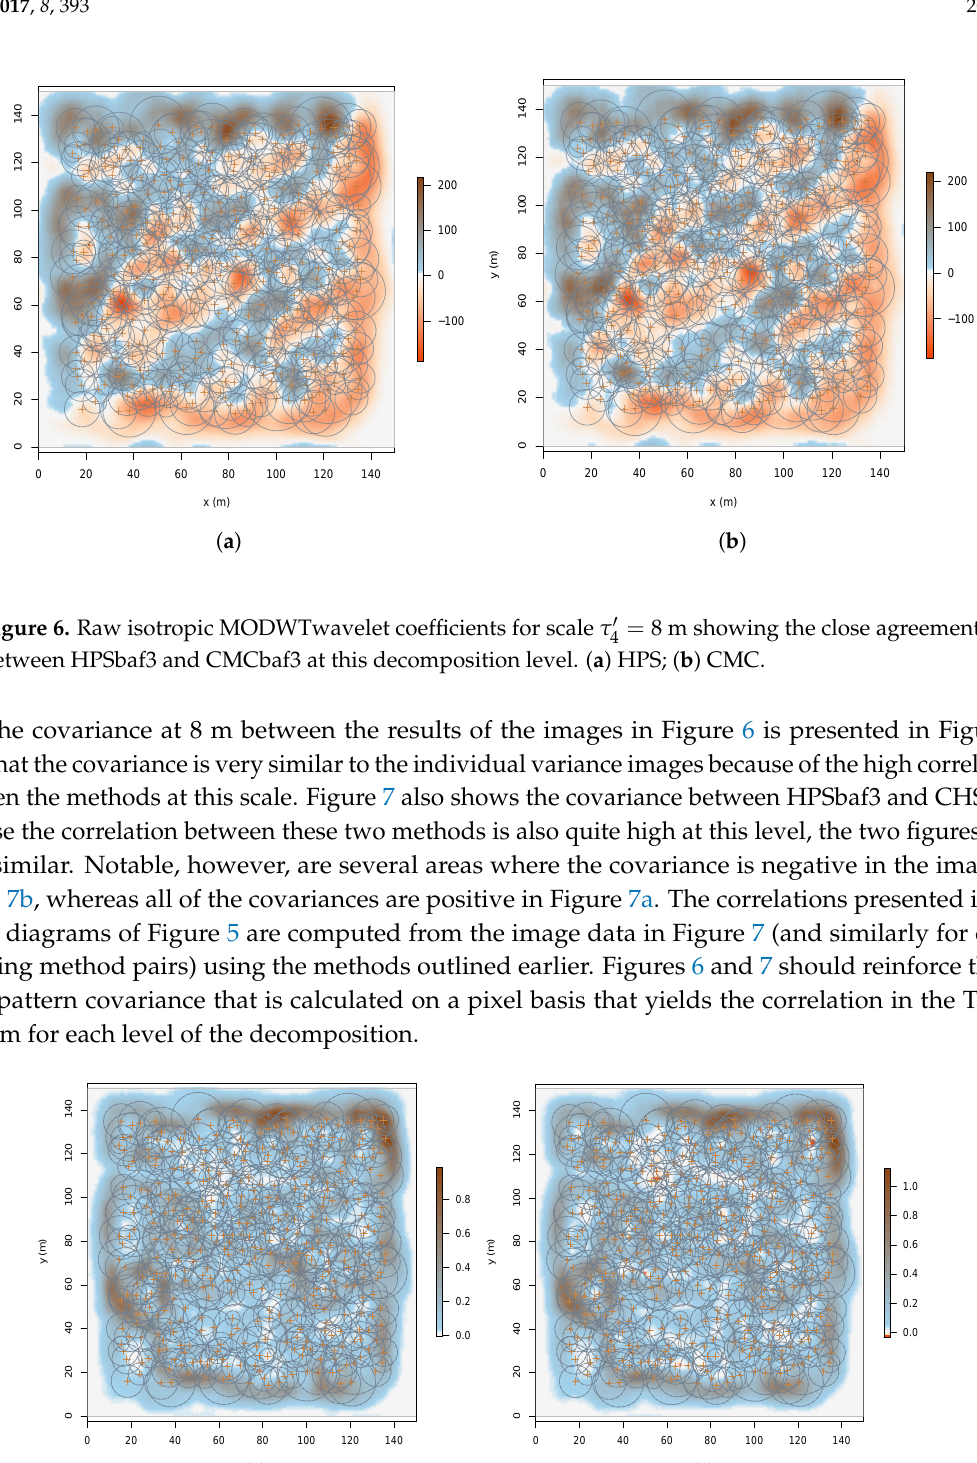
Figure 7. MODWT covariance images for scale τ (cid:48) and Y = CMCbaf3; and ( b ) X = HPSbaf3 and Y = CHSbaf3 at this decomposition